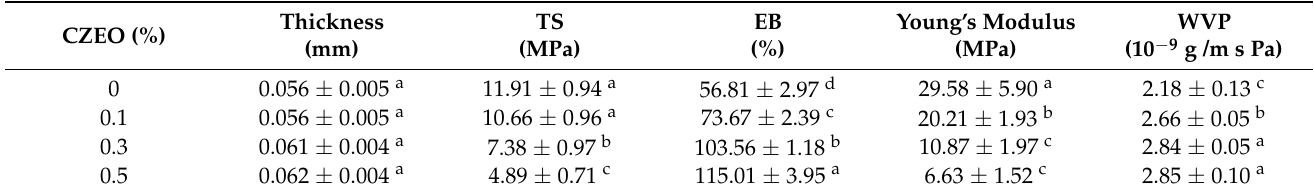
Table 1. Physical properties of GBS films containing